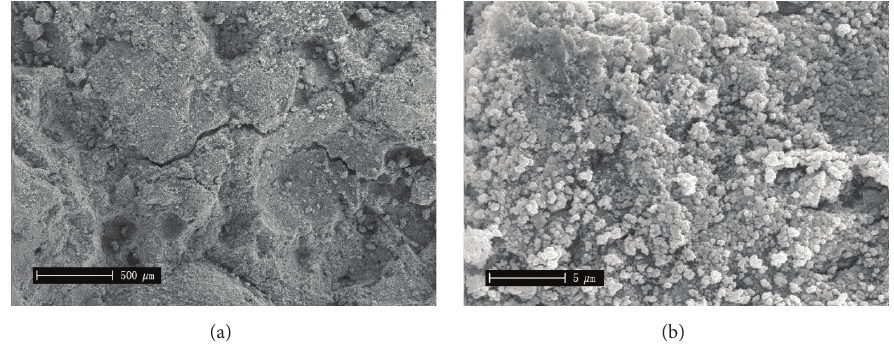
Figure 12: SEM images of microstructure of CFRC exposed at 800 ∘ C for 4 h at (a) 100x and (b) 10000x magnification.